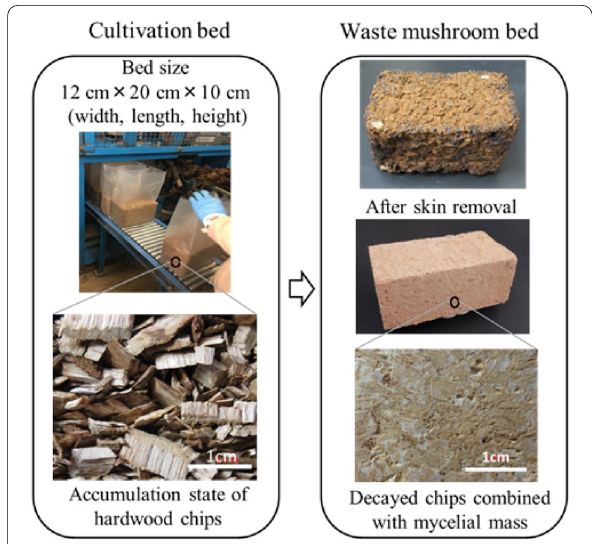
Fig. 2 Changes in the structure of a mushroom bed